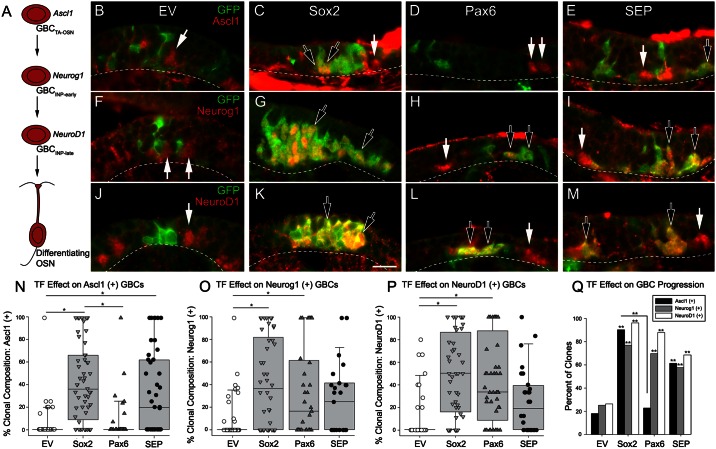
Sox2 transduction enhances Ascl1 expression, whereas Pax6 transduction leads to a reduction in Ascl1 expression and a reciprocal increase in the prevalence of downstream neural precursor markers.(A) A proneural bHLH cascade operates during olfactory neurogenesis and defines a hierarchy of GBCs as they progress from transit amplifying (TA) progenitor cells into differentiated neurons, by way of two immediate neural precursor (INP) stages. (B-M) At 8-days post-infection (9-days post-lesion), tissue was immunolabeled for Ascl1, Neurog1, and NeuroD1 along with GFP in clones derived from EV (B, F, J), Sox2 (C, G, K), Pax6 (D, H, L) and SEP (E, I, M) RVV-transduction. Hollow arrows mark GFP (+) cells within a given clone that co-express Ascl1, Neurog1, or NeuroD1. In contrast, solid arrows mark non-transduced, i.e., GFP-lacking, cells that express these factors. Dashed lines mark the basal lamina and scale bar in K corresponds to 20 μm in panels B-M. (N-P) Quantitative analysis of the effect of the various transduction conditions on the percentage of cells in a clone that express Ascl1 (N), Neurog1 (O) and NeuroD1 (P). For the graph, the percentage of cells marked by joint expression of the individual transcription factor and GFP within each clone are graphed in a box-and-whiskers scatter plot; the median number of each distribution is marked by the horizontal black line within the box. For Ascl1+ GBCs, the median percentages for EV vs. Sox2 vs. Pax6 vs. SEP are 0, 36, 0, 20, respectively. For Neurog1+ GBCs, the median percentages were 0, 37, 17, 25, respectively. Finally, for NeuroD1+ GBCs, the median values were 0, 50, 33, 19, respectively. Multiple pair-wise comparisons (horizontal line) were found to be statistically significant using Dunn’s method (* p < 0.05) following the demonstration of overall significance using Kruskal-Wallis One-Way ANOVA tests. (Q) Percentage of clones that contain cells positive for labeling with the bHLH factors. To compare percentages statistically, data were first arcsin transformed prior to normality testing, standard parametric ANOVA, and post-hoc Holm-Sidak pair-wise testing (**p < 0.01). Asterisks signify comparisons to EV, except for the comparison in number of Ascl1-conatining clones between Sox2 and Pax6 vectors, which is designated by the orthogonal lines.